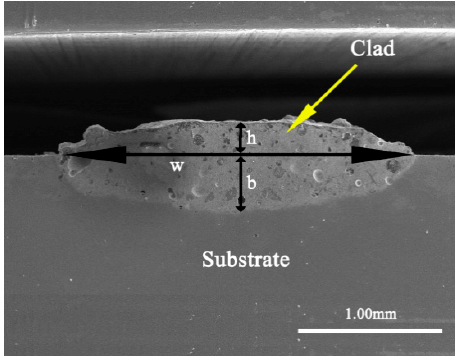
Figure 1. Schematic representation of geometrical characteristics in a single cladding.